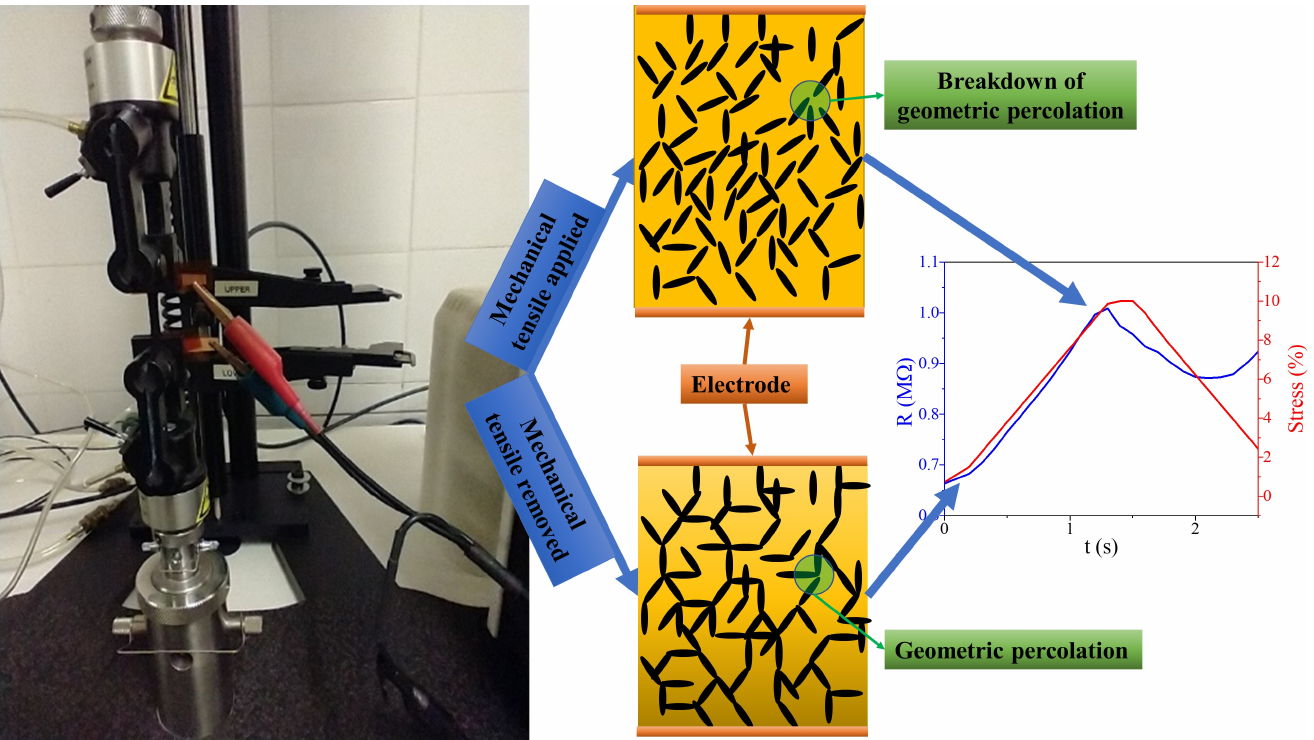
Figure 7. A schematic representation of the piezoresistivity test in conductive nanocomposites during stress